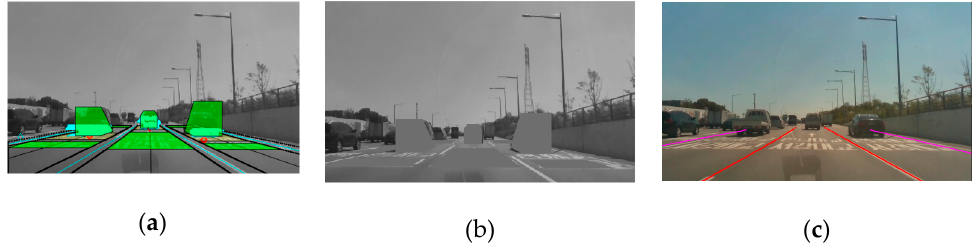
Figure 11. Complex road conditions: ( a ) template-based detection, ( b ) ITOM remapping on the origin